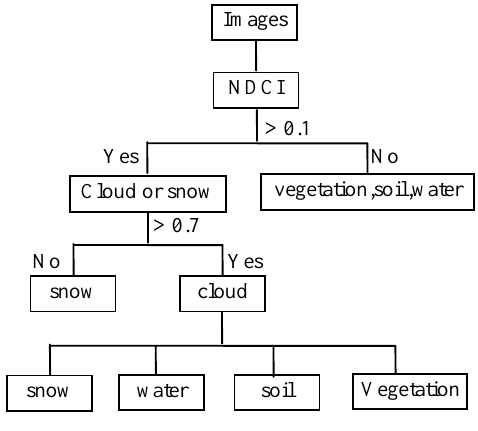
Figure3. The decision tree of cloud detection